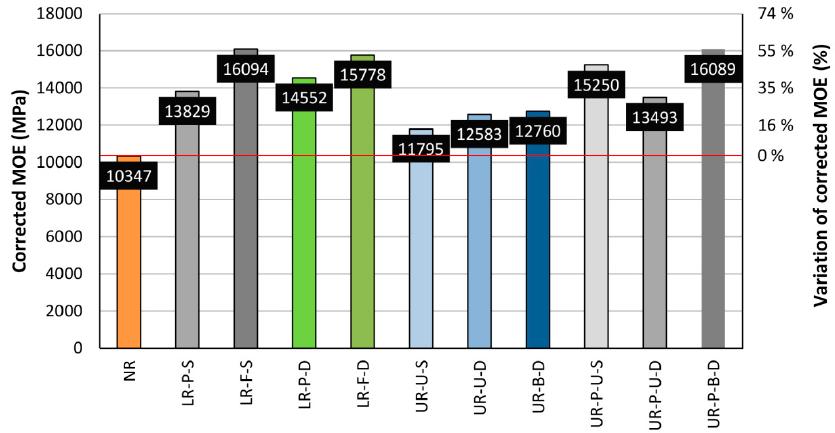
Figure 24. Average corrected MOE for each beam group. Horizontal red line. Average corrected MOE for NR beams.